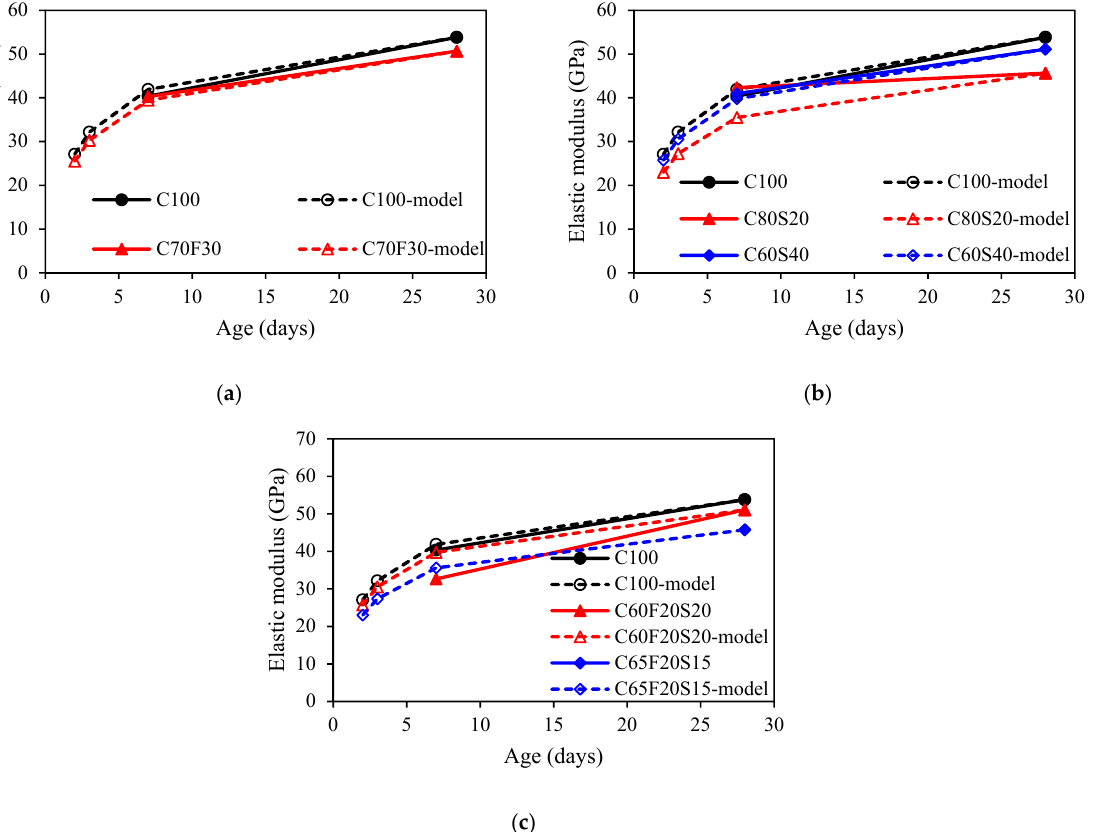
Figure 10. Comparison of the elastic modulus development between experimental results and model predictions: ( a ) fly ash group; ( b ) GGBFS group; ( c ) ternary binder group.